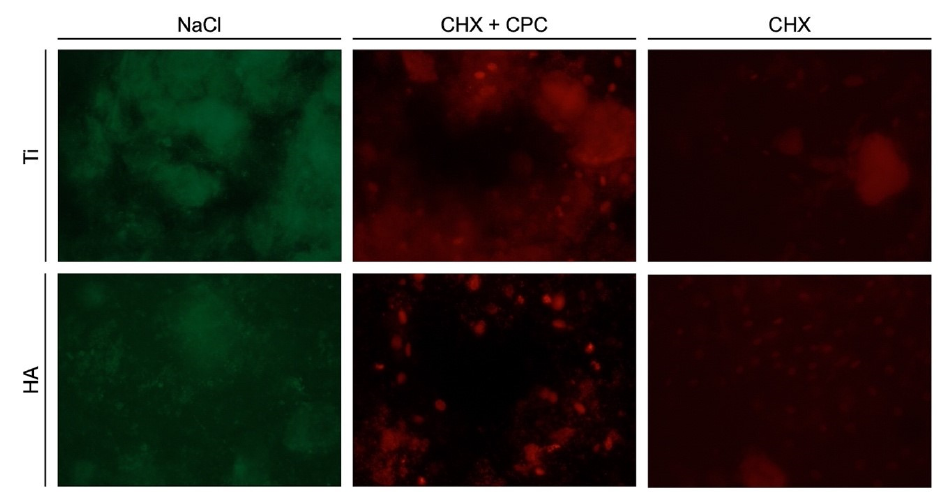
Figure 4. 48-h-old biofilm on Ti and HA surfaces after treatment with NaCl, CHX + CPC or